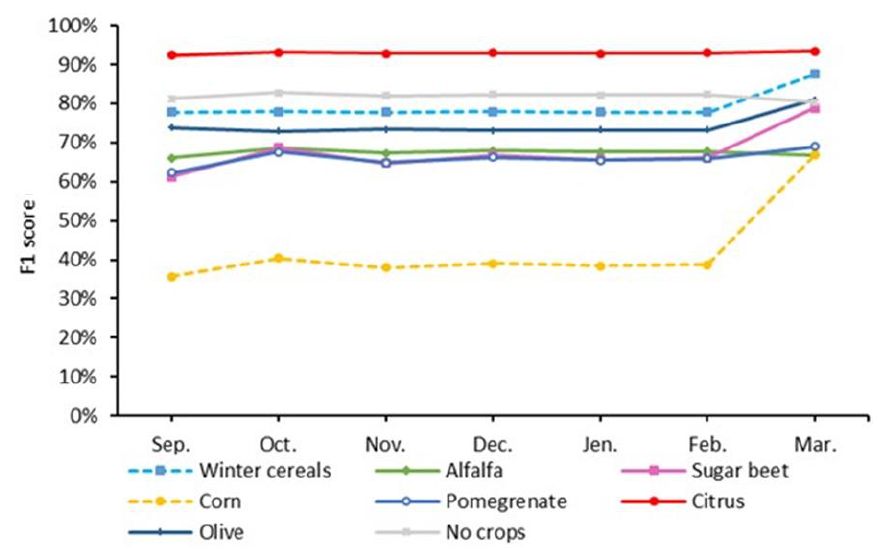
Figure 16. Variations in the F1 scores over time for experiment 5 (Sentinel-1 + Sentinel-2).